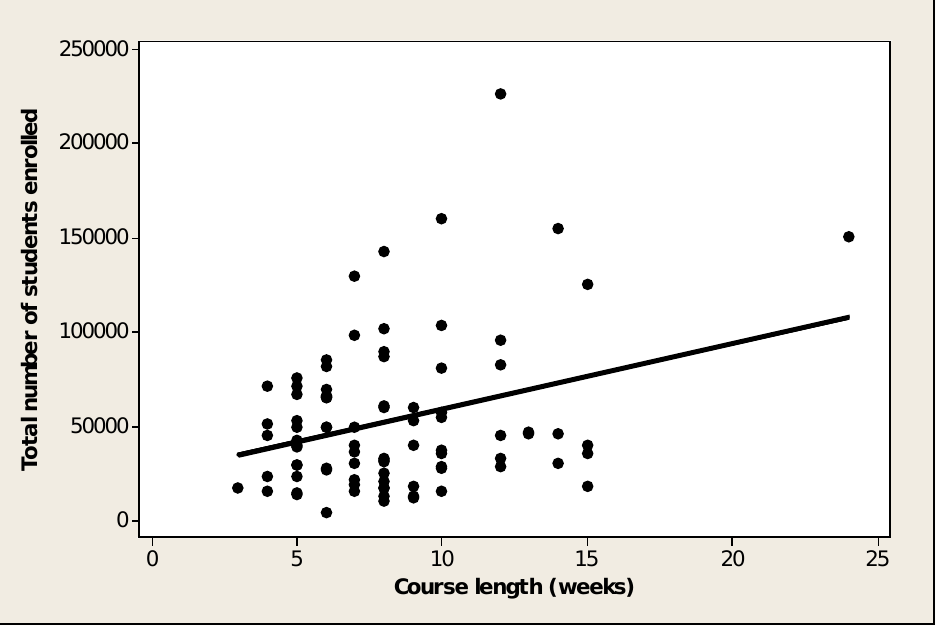
Figure 3 . Scatterplot of total enrolment numbers plotted against course length for the sampled courses ( n =